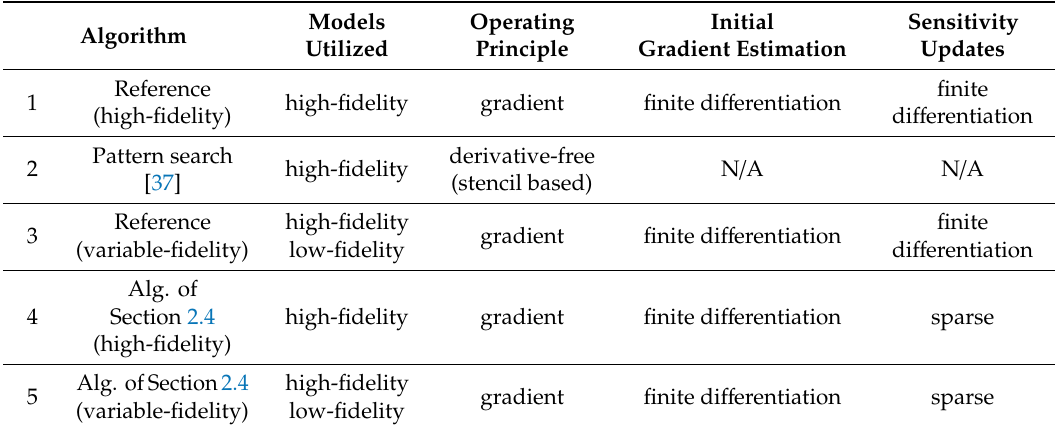
Table 1. Main features of the optimization procedures utilized in this work (including